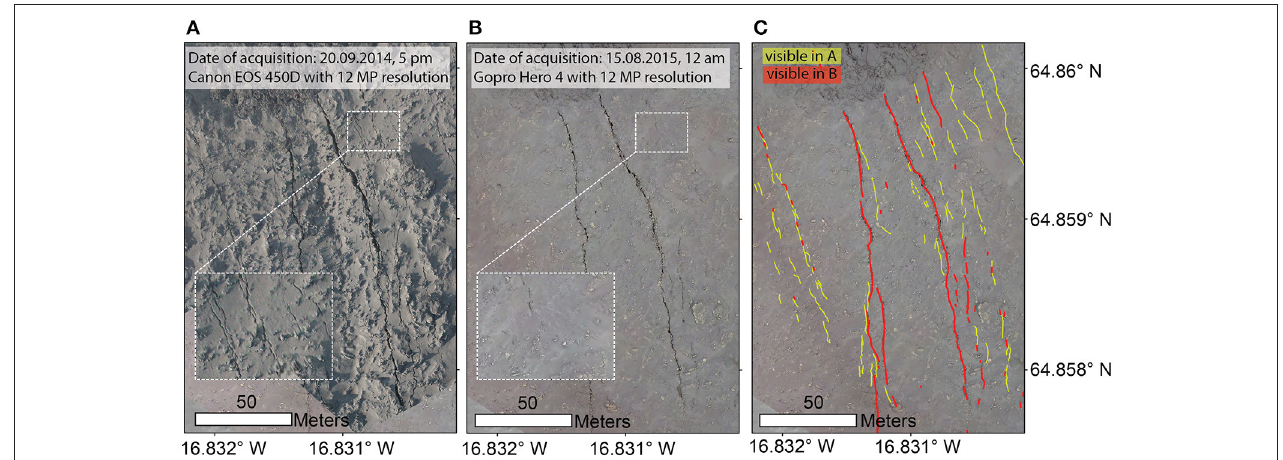
FIGURE 7 | Example of limitations- (A) Close-range aerial image taken during the eruption in September 2014, showing multiple small-scale fractures near the two main larger fractures. Image taken using hand held digital SLR camera with 16 megapixels in the early morning hours. (B) UAV camera images used in this study show larger fractures in detail; however, small-scale fractures are hard to identify. Image taken using GoPro camera at noon. Differences between (A) and (B) are due to camera type, time of image acquisition, and time lag between fracture formation and image acquisition. (C) Lineament map of the two images illustrates differences. Especially in small-scale fractures, local sinkholes and disconnected fractures are predominant, while large parts of the fractures are obscured and hidden by fine-grained deposits (i.e., ash and